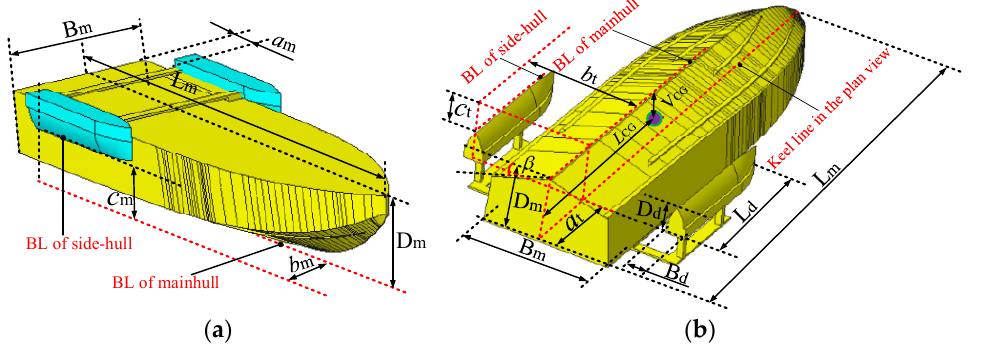
Figure 1. Main geometric characteristics of the hull in different navigation states: ( a ) monomer-form state (MFS) and ( b ) trimaran-form state (TFS). Table 1. Primary geometric details of the planing hull at each navigation